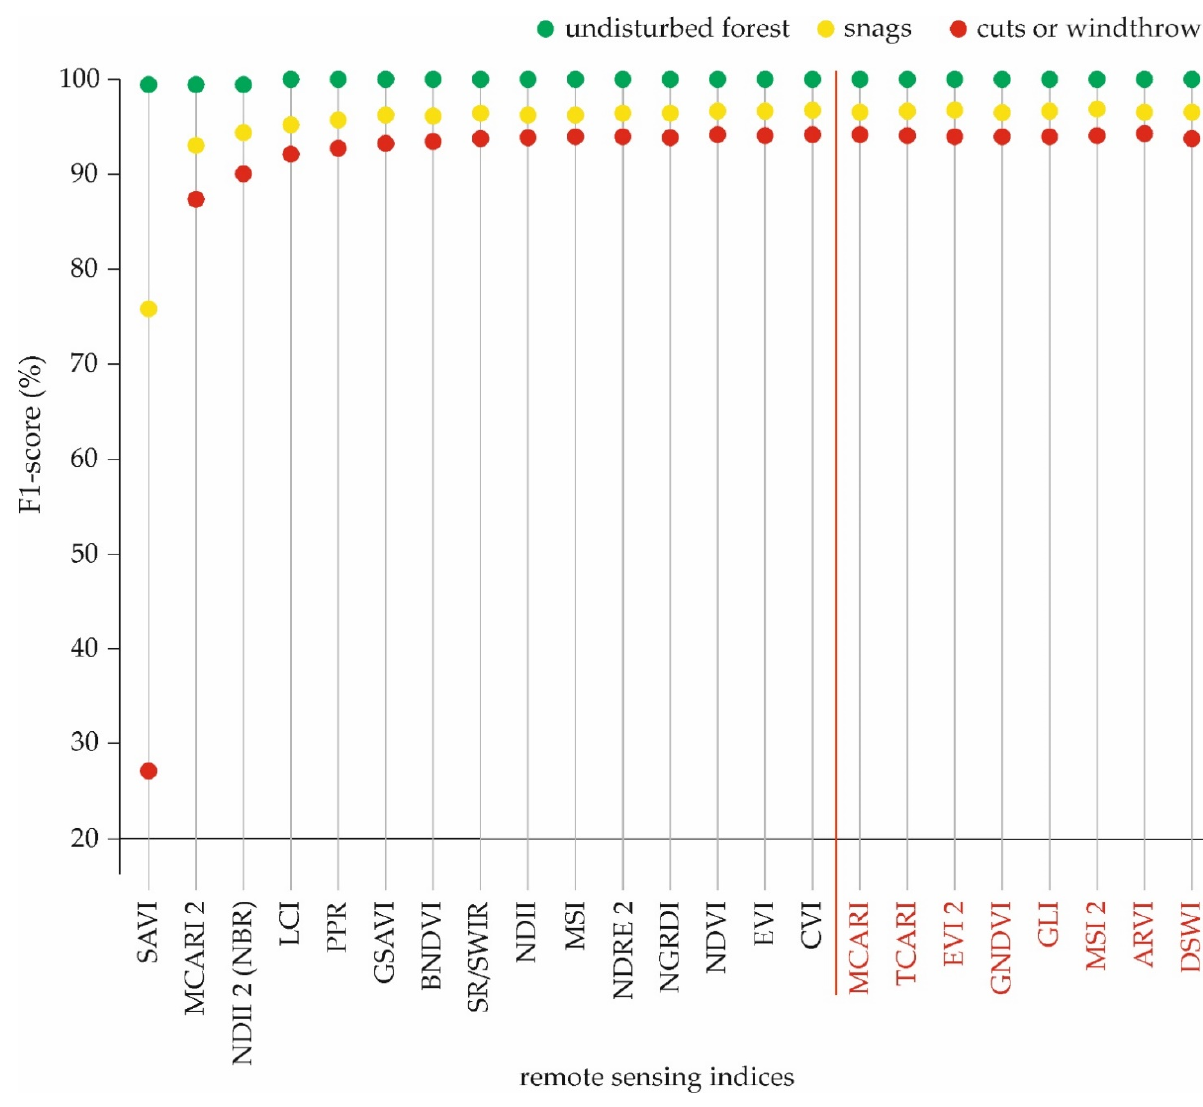
Figure 5. Increase of informationality of remote-sensing indices measured by OA and F1-score for analyzed classes (indices are presented in the order of informationality: from the most significant SAVI on the left, to the least significant DSWI). Red marked indices were not used for analyses.